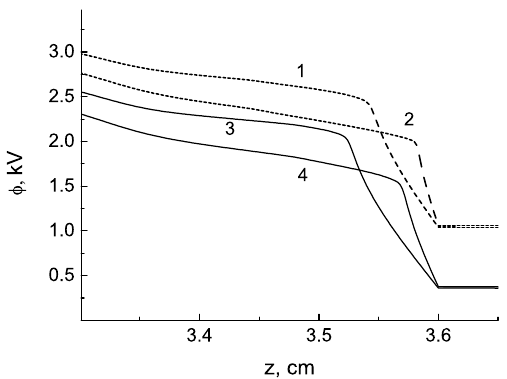
Figure 10. Potential profile over z for different times, t = 381.1 ns (1) and 382.8 ns (2) for the case without the grounded substrate and t = 374.5 ns (3) and 375 ns (4) for the case with GR substrate, argon, U = 4.9 kV.